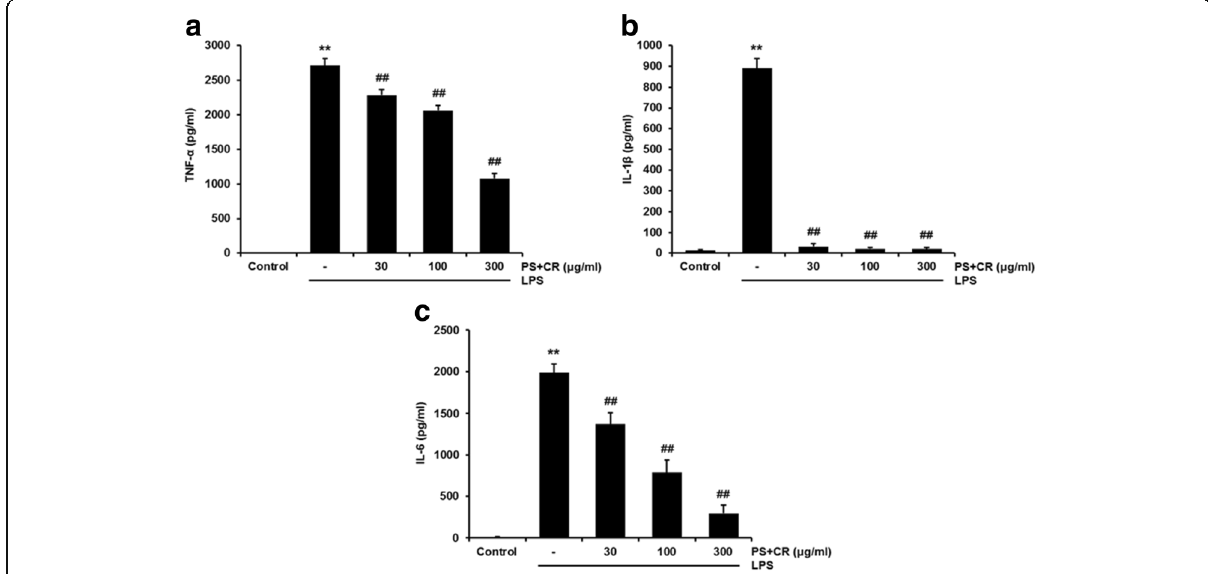
Fig. 4 Inhibition of the LPS-induced secretion of pro-inflammatory cytokines by PS + CR. RAW 264.7 cells were treated with 30 – 300 μ g/ml of PS + CR for 1 h prior to the addition of LPS (1 μ g/ml) and further incubated for 24 h. Levels of TNF- α ( a ) IL-1 β ( b ) and IL-6 ( c ). As detailed in the Methods section, the concentrations of cytokines in the culture medium were assayed using a kit. Values represent the mean ± S.D. of three independent experiments (significant compared to the control, ** p < 0.01; significant compared to LPS alone, ## p <